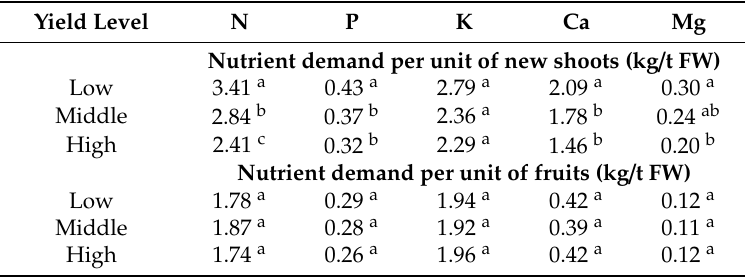
Table 4. Nutrient demand per unit of total new shoots (leaves, twigs and fruits) and fruits under di ff erent yield level. Nutrient demand per unit of new shoots (kg / t FW) = nutrient accumulation in new shoots / fruit yield; nutrient demand per unit of fruits (kg / t FW) = nutrient accumulation in fruit / fruit yield. The di ff erent letters (a–c) in the table represent significant di ff erences ( p < 0.05) among